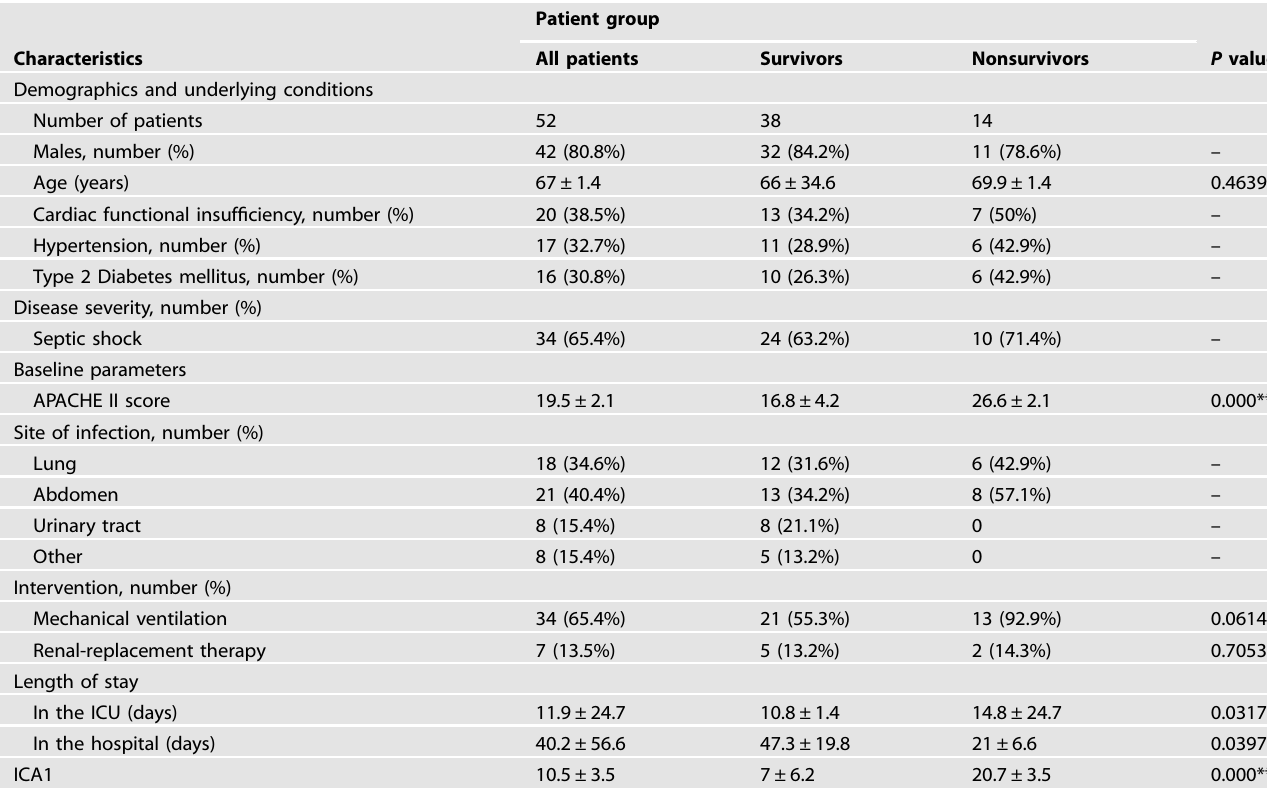
Table 1. Baseline clinical characteristics and ICA1 levels of the study